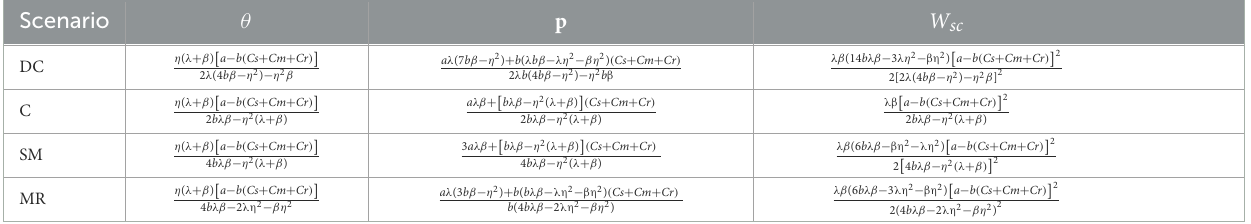
TABLE 2 Equilibrium solution comparison in four decision-making modes.